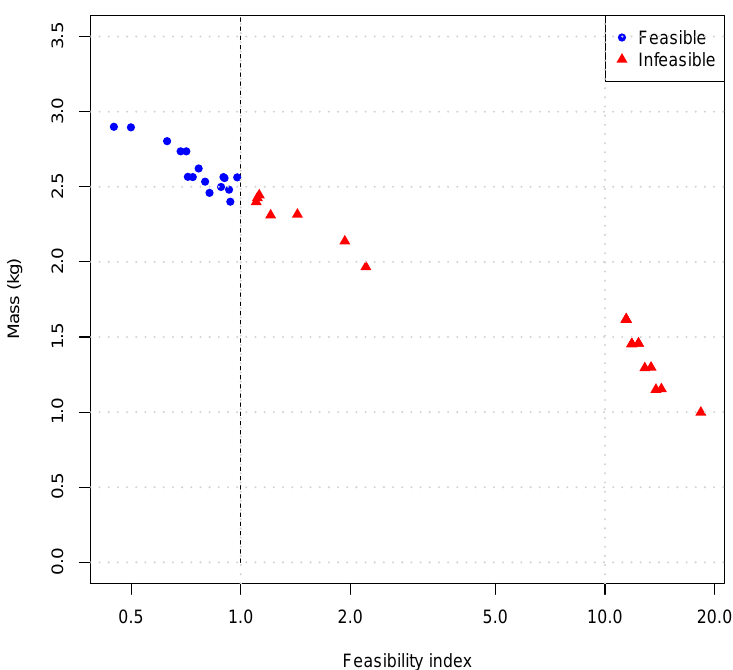
Figure 22. Second DOE: Pareto front of the optimum mass for different feasibility indices with α = 0.5.